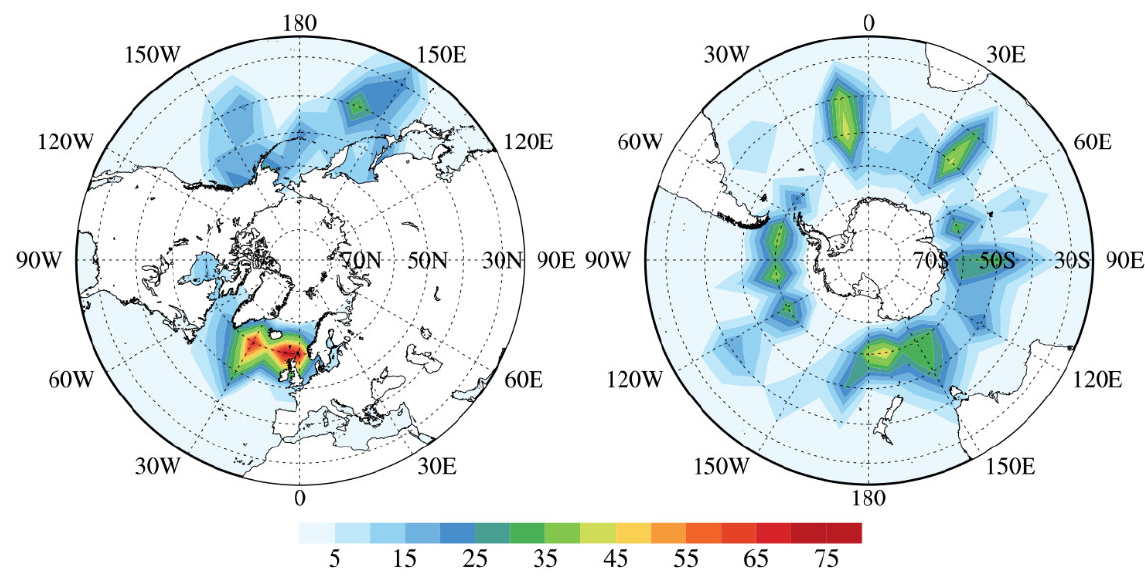
Figure 2. Number of selected radar profiles within 10° × 10° boxes.